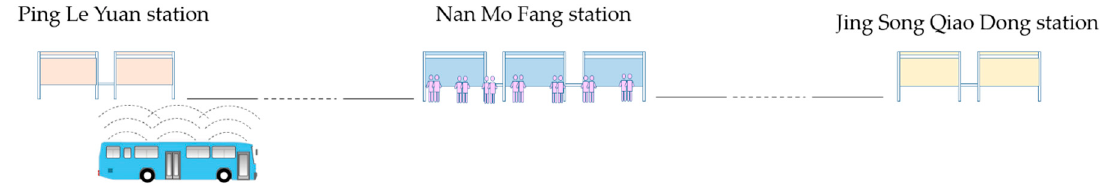
Figure 3. The location volunteers out of the bus.